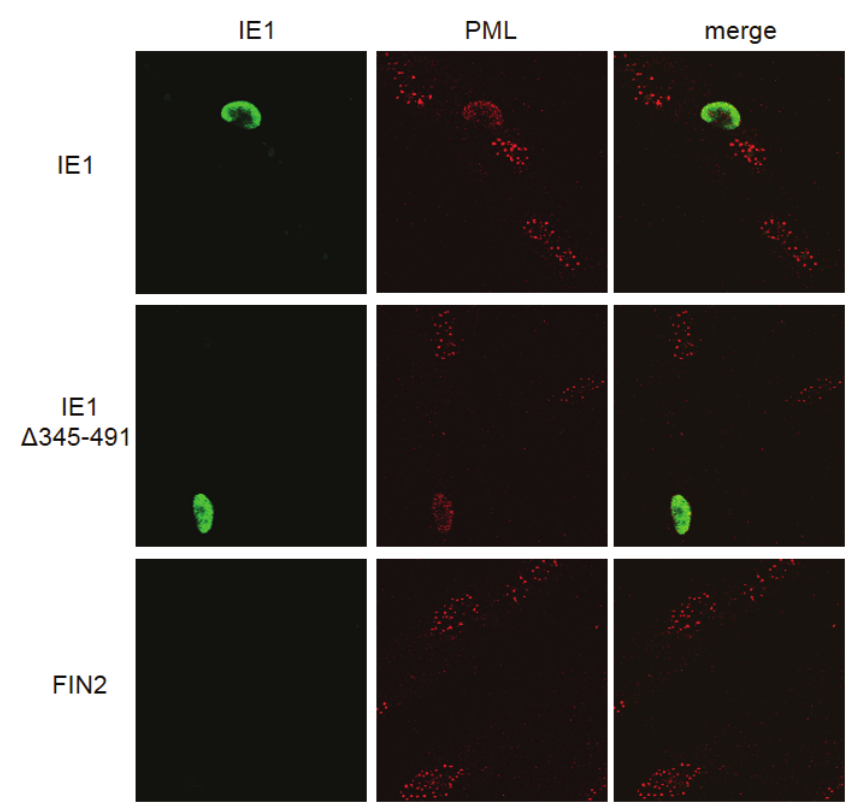
Figure 3. Disruption of ND10 structures in cells expressing IE1 and the C-terminal truncation mutant. Immunofluorescence images of IE1 and Promyelocytic leukemia protein (PML) in fibroblast cells. MRC5 cells were nucleofected with the indicated constructs. At 24 hours after nucleofection cells were fixed in methanol and reacted with mouse monoclonal anti-IE1 antibody (Mab810) followed by anti-mouse alexafluor 488 as secondary antibody. The cells were then exposed to rhodamine conjugated anti PML antibody (PGM3). IE1 reactivity is visualized in green (left column), PML reactivity is visualized in red (middle column) and merged images are shown in the right